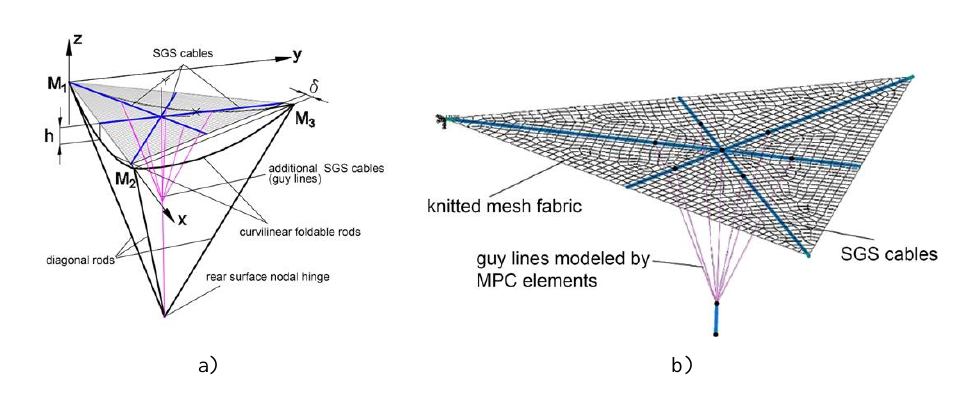
Fig. 10. The single facet of the reflector framework and the finite element model of knitted mesh fabric with SGS cables.